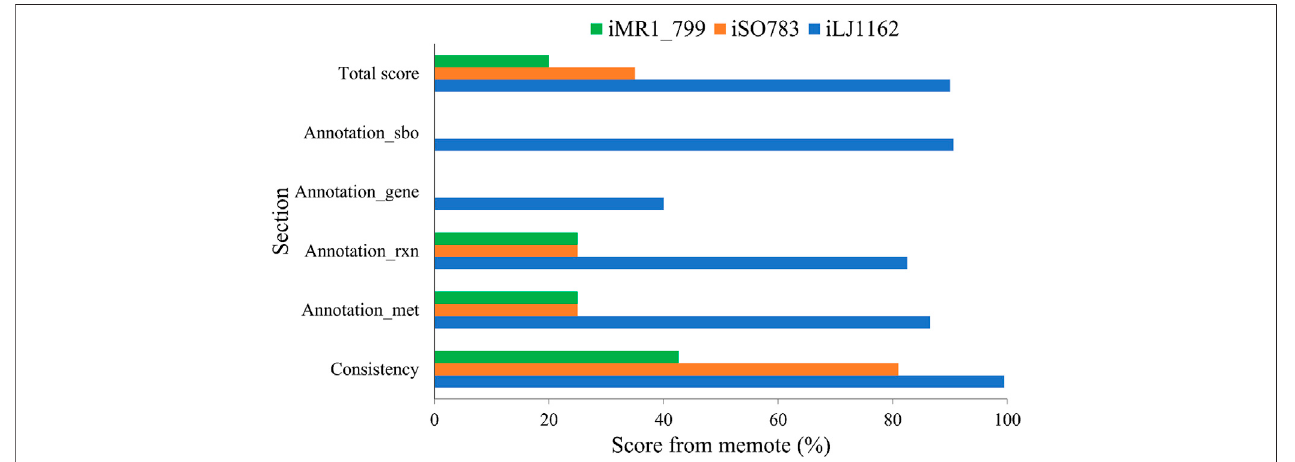
FIGURE 4 | Evaluation of genome-scale metabolic models of S. oneidensis MR-1 using MEMOTE.